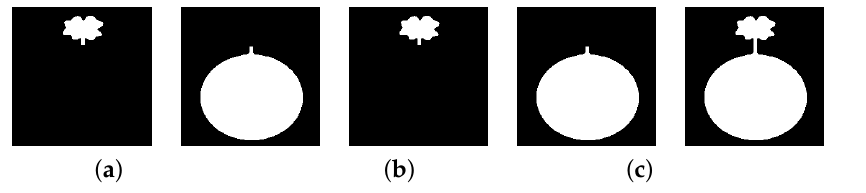
Figure 22. Extracted regions for k = 2 and different values of d ( a ) d = 25; ( b ) d = 40; ( c ) d = 50.